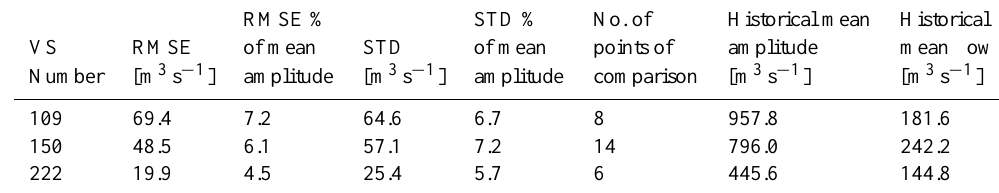
Table 2. Results for discharge calculations using method 1.